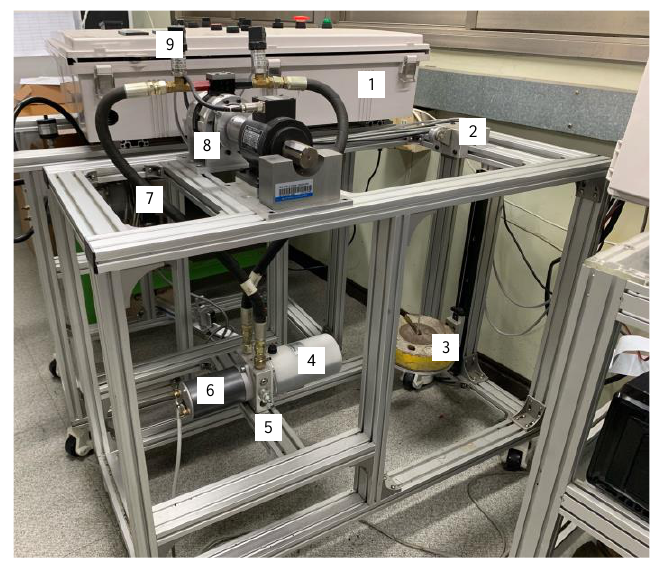
Figure 12. Experimental apparatus with 1—Control box, 2—Pulley and cable, 3—Attached weight, 4—Oil tank, 5—Pump and valves, 6—Electric DC motor, 7—Pipeline, 8—Rotary actuator, 9—Pressure sensor.